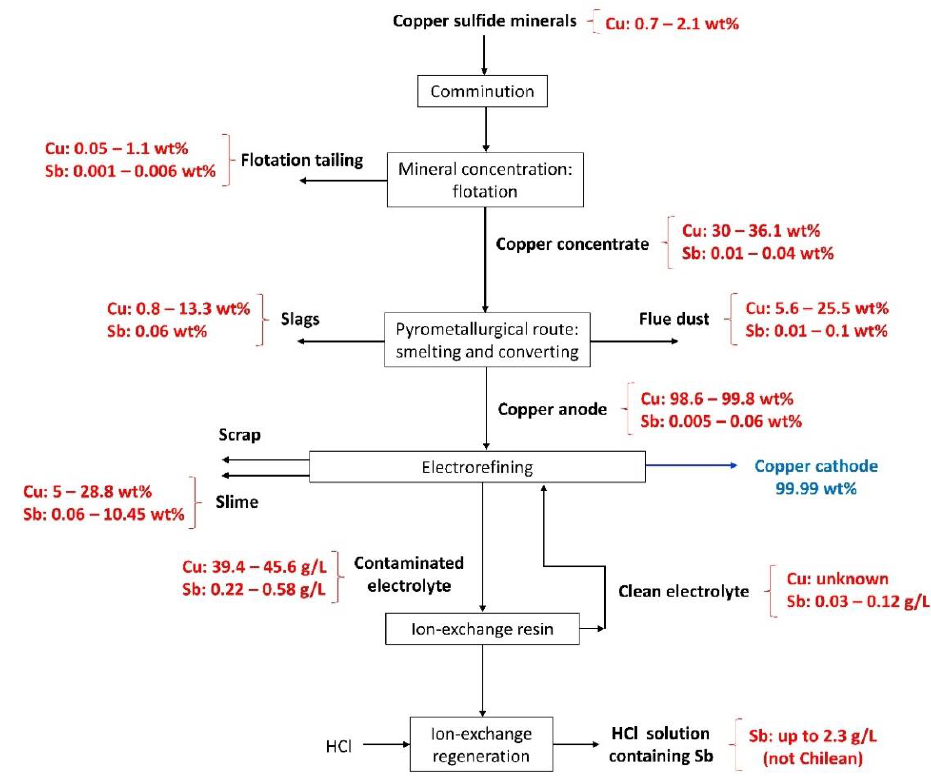
Figure 9. Flowchart of the copper production from sulfide minerals showing the concentration ranges of copper and antimony in the main Chilean process stages.